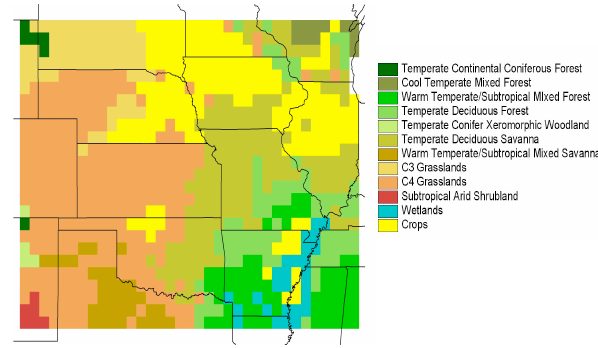
Fig. 2. The modified VEMAP version 2 vegetation classification.